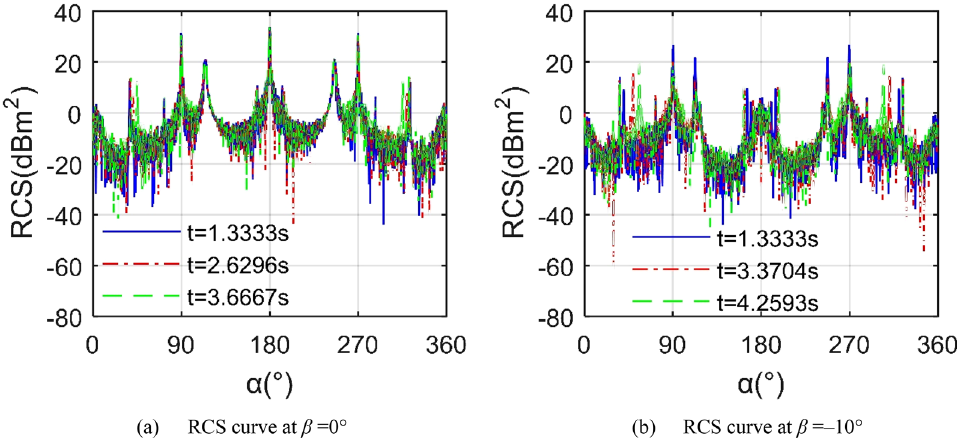
Figure 16. RCS of the aircraft in Z4 mode, f RH = 6 GHz, ω m1 = ω m2 = 0.1963 rad/s.